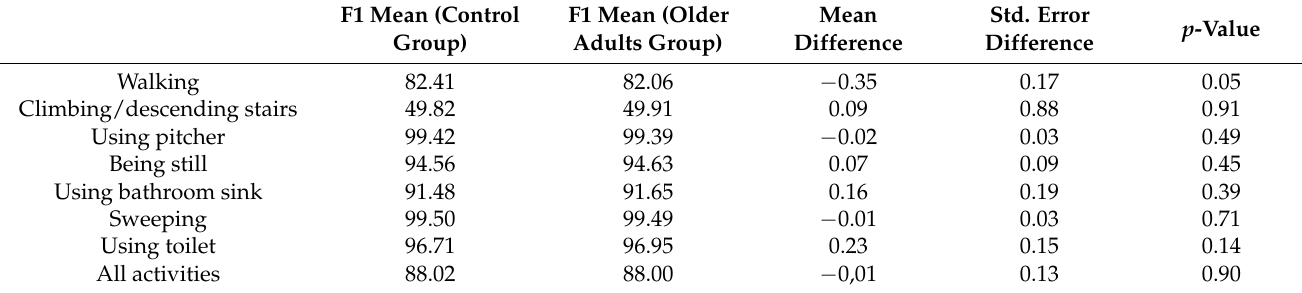
Table 5. Student’s t -test result. Comparison of F1 measure between older adults and control group.